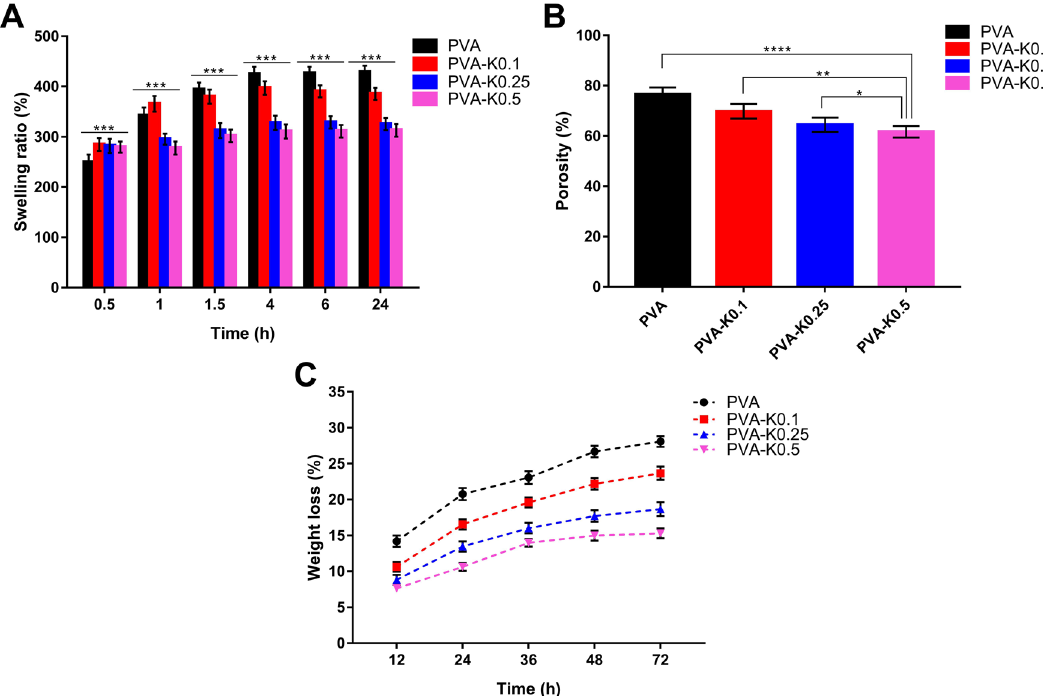
Figure 6. ( A ) Swelling ratio, ( B ) porosity, and ( C ) in vitro degradation for PVA/Kaolin composite hydrogel membranes in comparison with PVA hydrogel membrane. Data are presented as means ± SD (***p < 0.001, **p < 0.01, and *p <